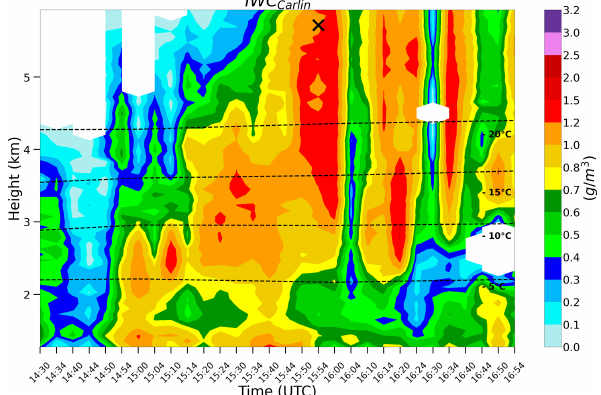
Figure 8. RSVPs of IWC Carlin at ranges between 15.5 and 20km from the DOW on 10 December 2015 between 14:30 and 16:54UTC. Overlaid dashed lines display the − 5, − 10, − 15, and − 20 ◦ C isotherms from ERA5 at the DOW location. The collocated data point is indicated by the black cross.